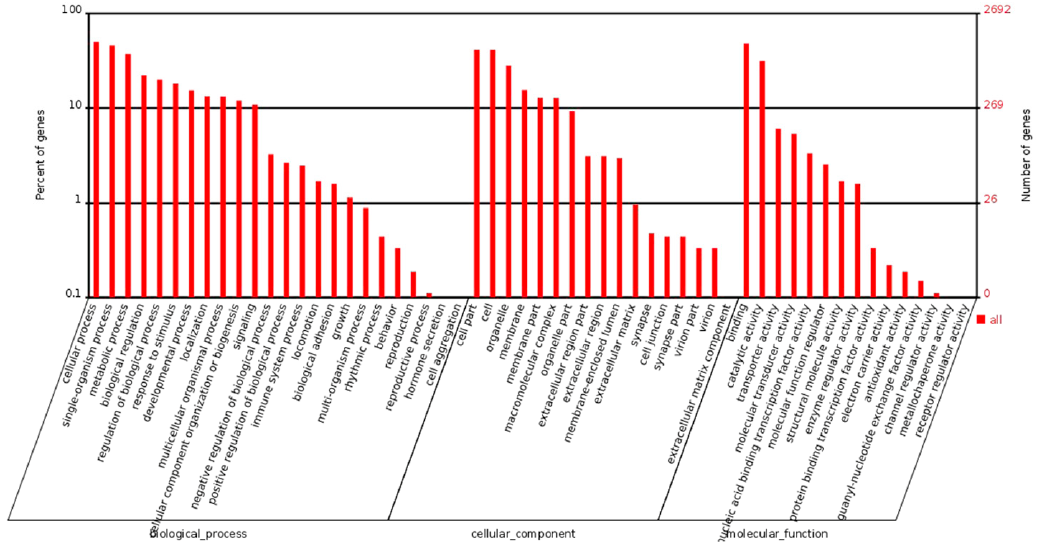
Figure 4. GO classification of DEGs. Biological process, cellular component and molecular function were analyzed.